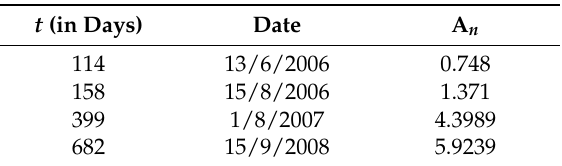
Table 5. Change points in the estimated positive jump time series of NASDAQ index with the corresponding test statistic value.